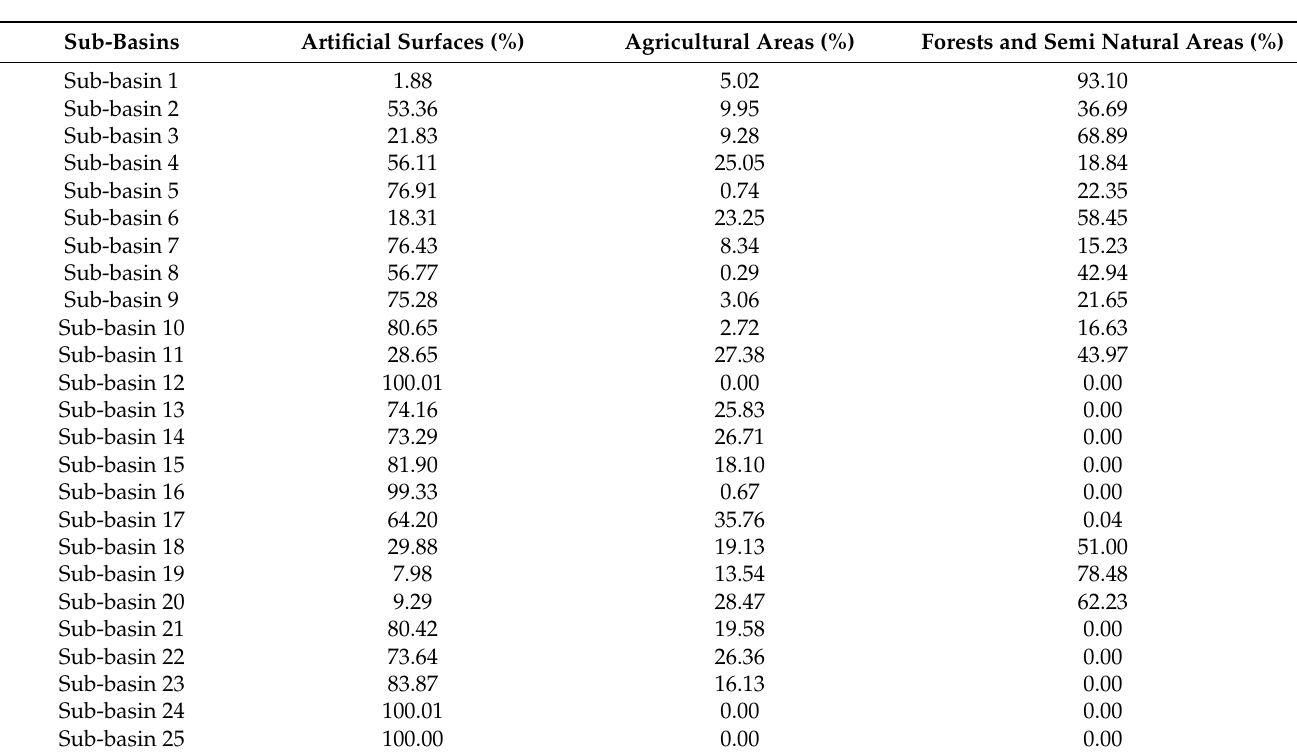
Table A2. Land use categories of the study area at sub-basin level. Artificial surfaces (i.e., urban fabric, industrial, commercial and transport units), agricultural areas (i.e., arable land, pastures and heterogeneous agricultural areas) and forests and semi natural areas (i.e., forests, scrub and herbaceous vegetation